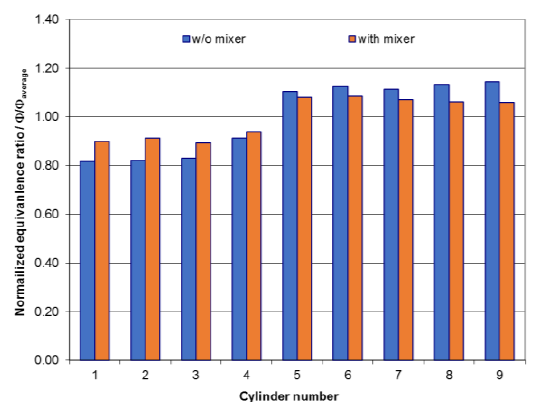
Fig. 2. Comparison of normalized equivalence ratio of two fuel system concepts for biogas relevant flow conditions